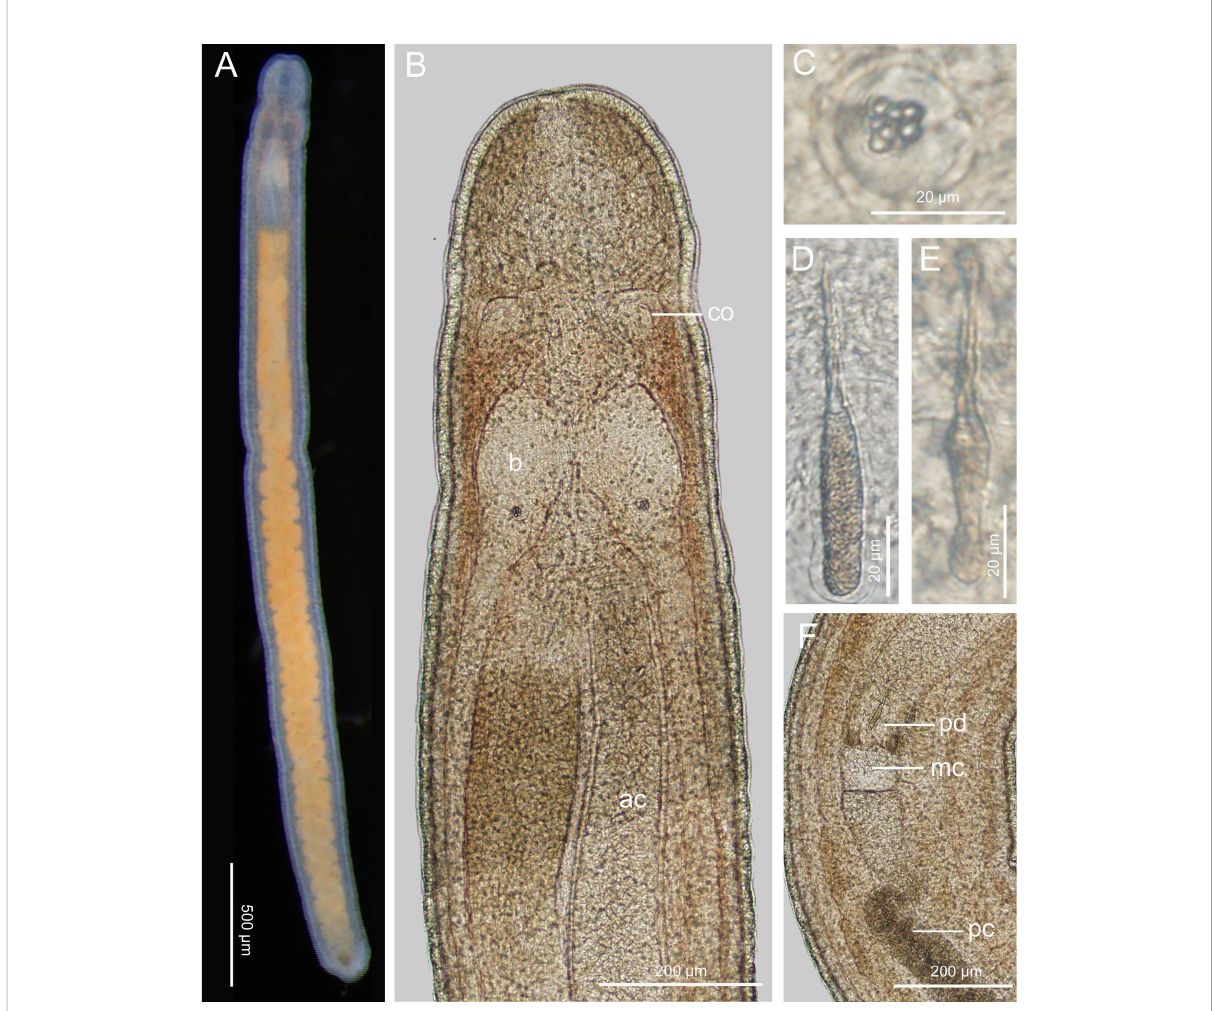
FIGURE 10 Ototyphlonemertes ( Procso ) coralli sp. nov. (A) Photograph of a live specimen; (B) composite photomicrograph of a squeezed specimen; (C) statolith; (D, E) central stylet and basis; (F) photomicrograph of partial proboscis from a squeezed specimen. ac, anterior chamber of proboscis; b, brain; co, cerebral organ; mc; middle chamber of proboscis; pc, posterior chamber of proboscis; pd; proboscis